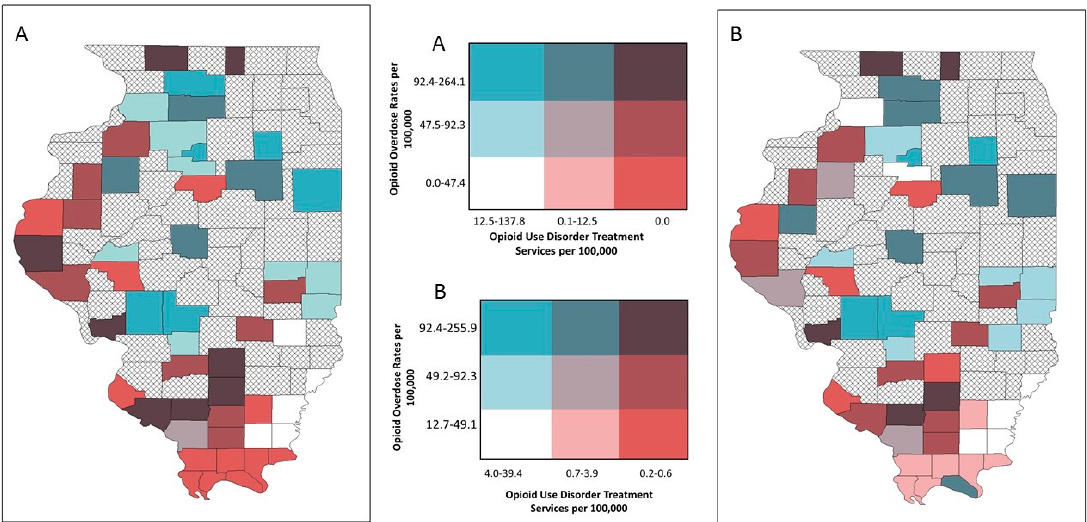
Figure 8. Bivariate choropleth maps of local health department services and disease burden, respondent rural counties, Illinois: opioid-use disorder (OUD) treatment services and opioid overdose rates; ( A ) crude rates ( B ) empirical Bayes estimated rates.